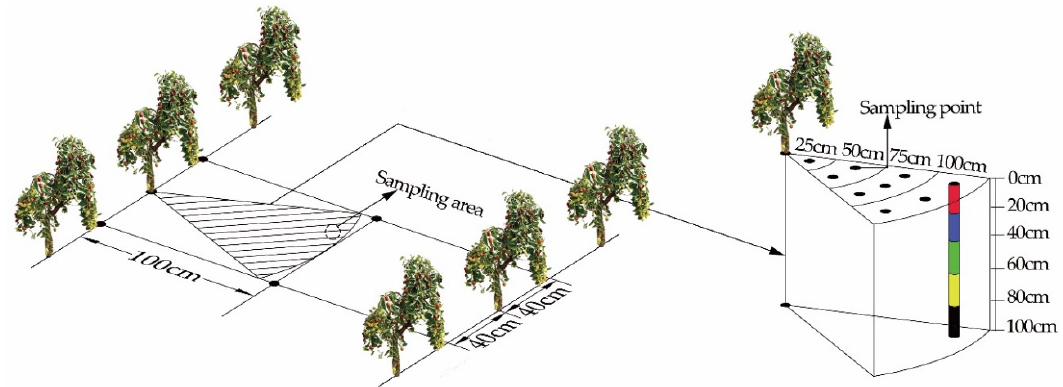
Figure 2. Schematic of root sampling.